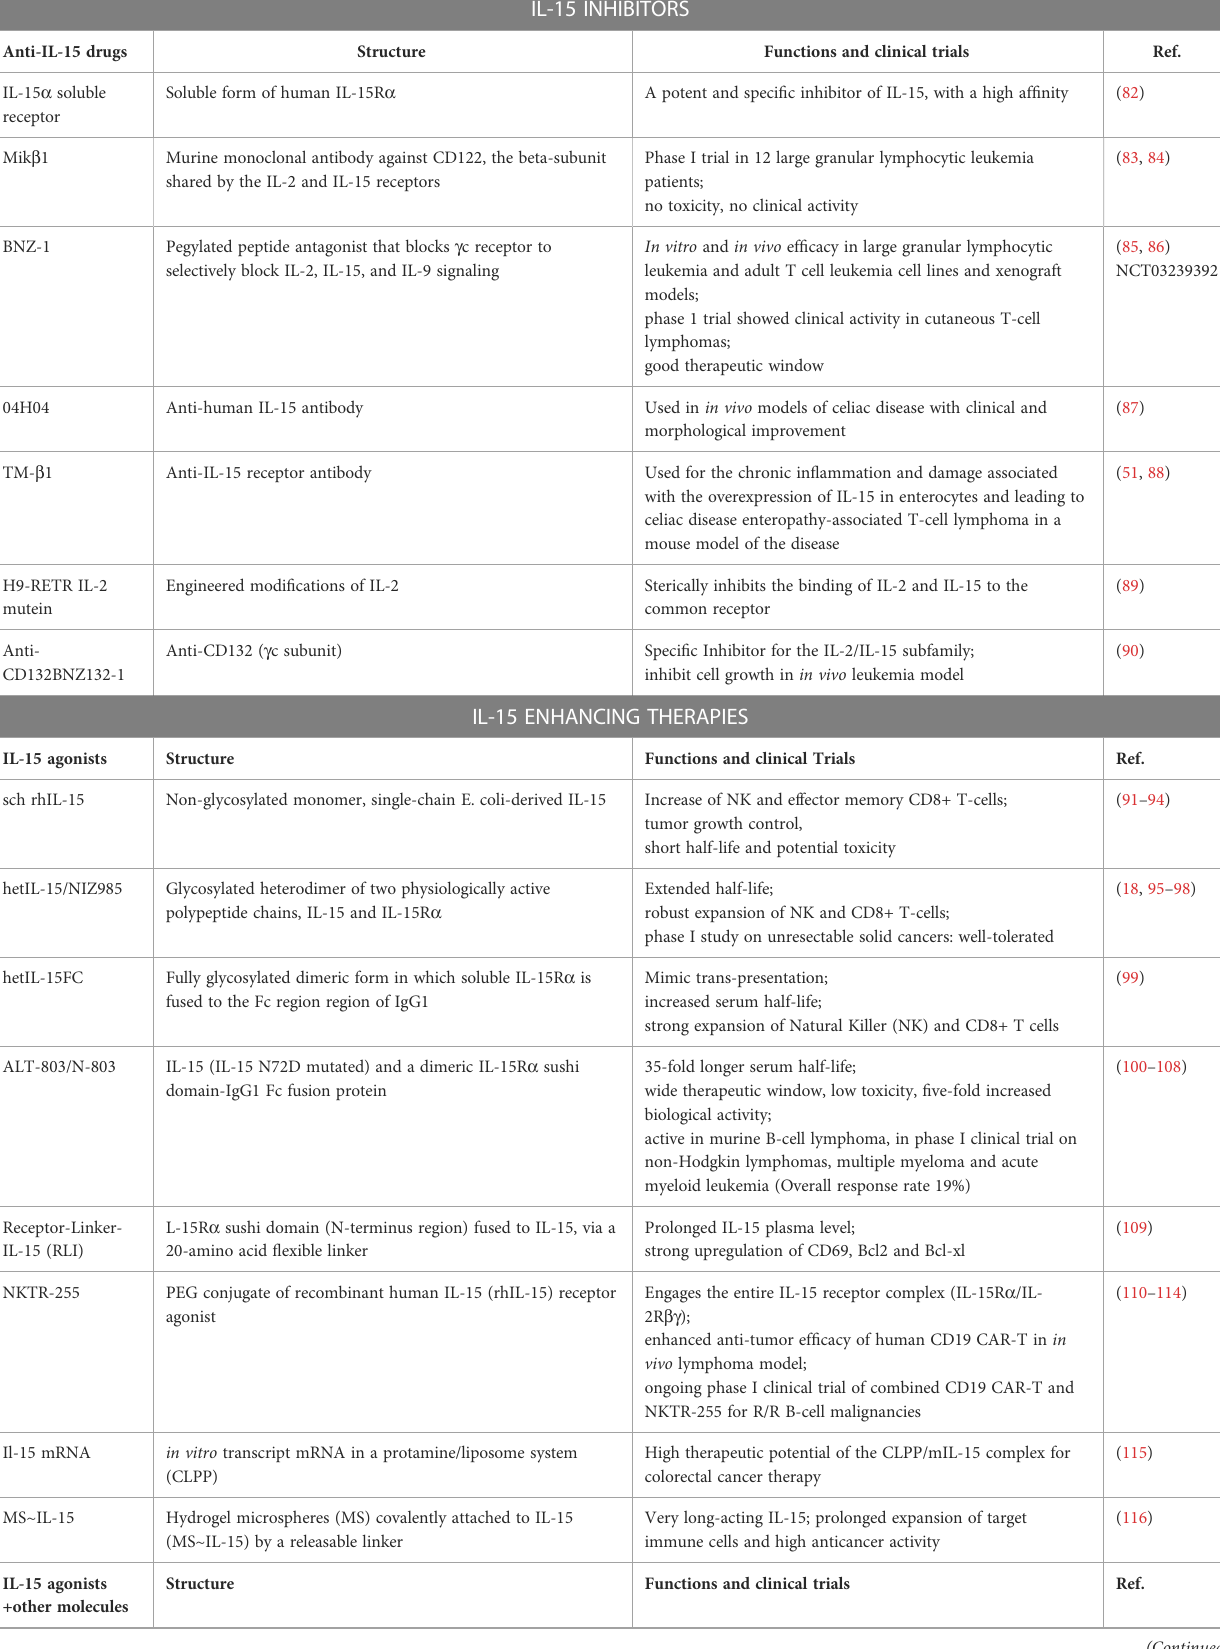
TABLE 1 IL-15-related therapeutic interventions: IL-15 is used in hematologic malignancies using anti-IL-15 drugs, IL-15 agonists, chimeric compounds of IL-15 and other molecules, and a combination of IL-15 with adoptive cell therapies. IL-15 INHIBITORS Anti-IL-15 drugs Structure Functions and clinical trials